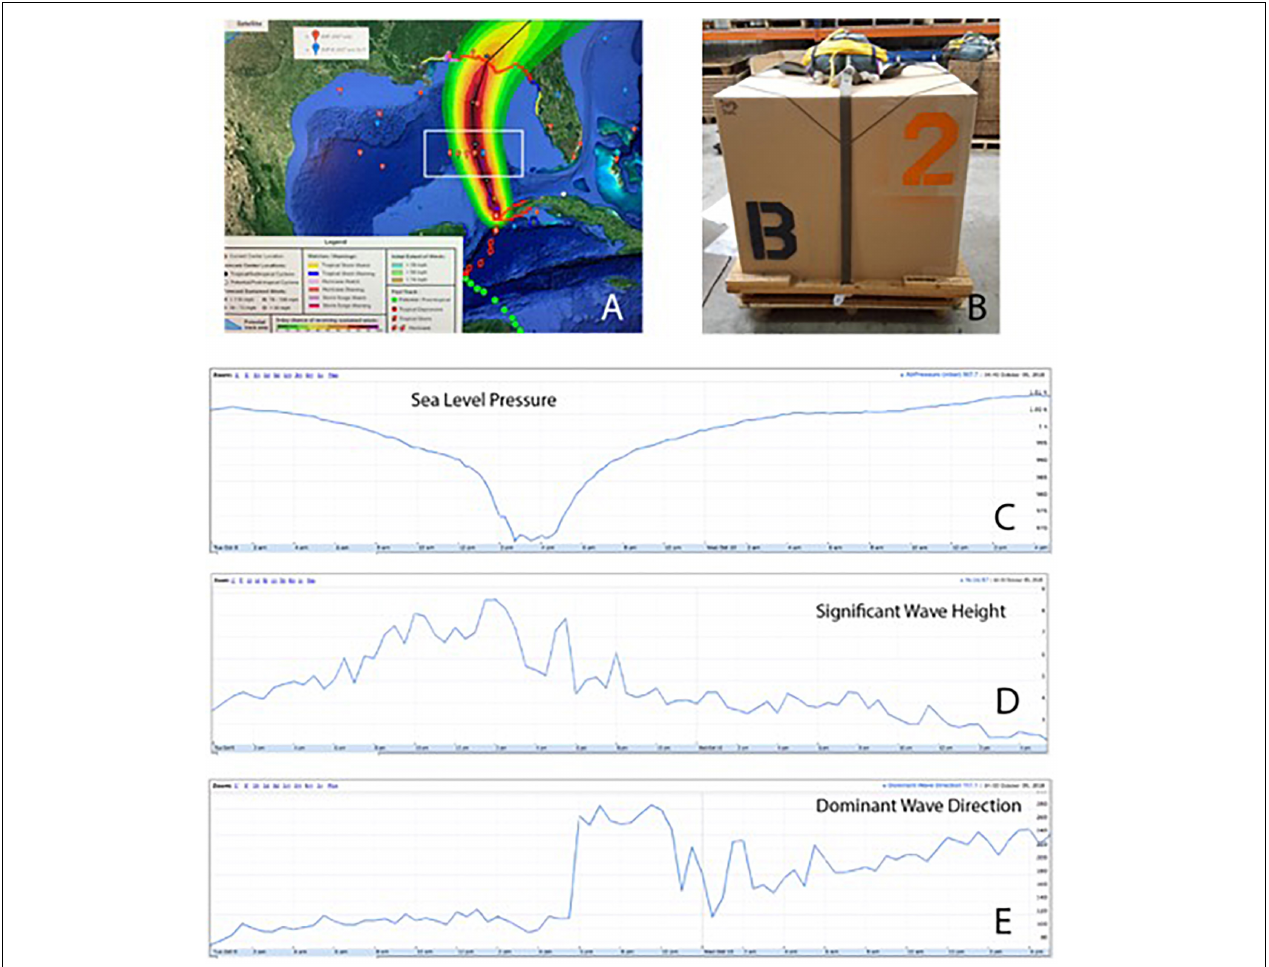
FIGURE 5 | (A) Deployment location of 10 drifters ahead of Hurricane Michael (white box). The drifters were deployed on October 8, 2018, from a C-130J aircraft by the United States Air Force Reserve’s 53rd Weather Reconnaissance Squadron “Hurricane Hunters.” The transect was located approximately 24 h ahead of the predicted track of the storm, which is shown by green and red symbols. The forecast for the wind intensity is overlaid as a contour plot (see legend in panel A ). The storm data were provided by NOAA’s National Hurricane Center (NHC). The 10 drifters were air-deployed at five stations using the deployment package shown in panel (B) . Each box contained one SVP-B drifter and one directional wave spectra (DWS) drifter. One SVP-B drifter measured a minimum air pressure of 967.7 hPa inside the eye of the hurricane (C) . The DWS drifter deployed at the same location measured a maximum significant wave height of 8.7 m (D) . Note the sharp change of the dominant wave direction due to the hurricane moving over the DWS drifter (E) and the rapid decay of the wave field in the wake of the storm.